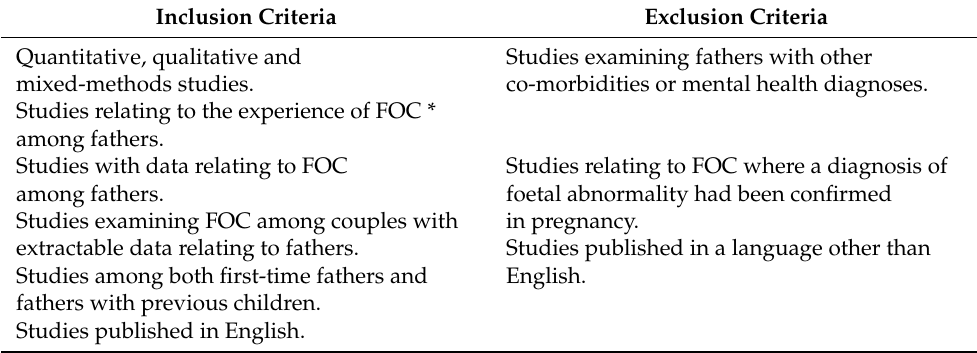
Table 1. Inclusion and exclusion